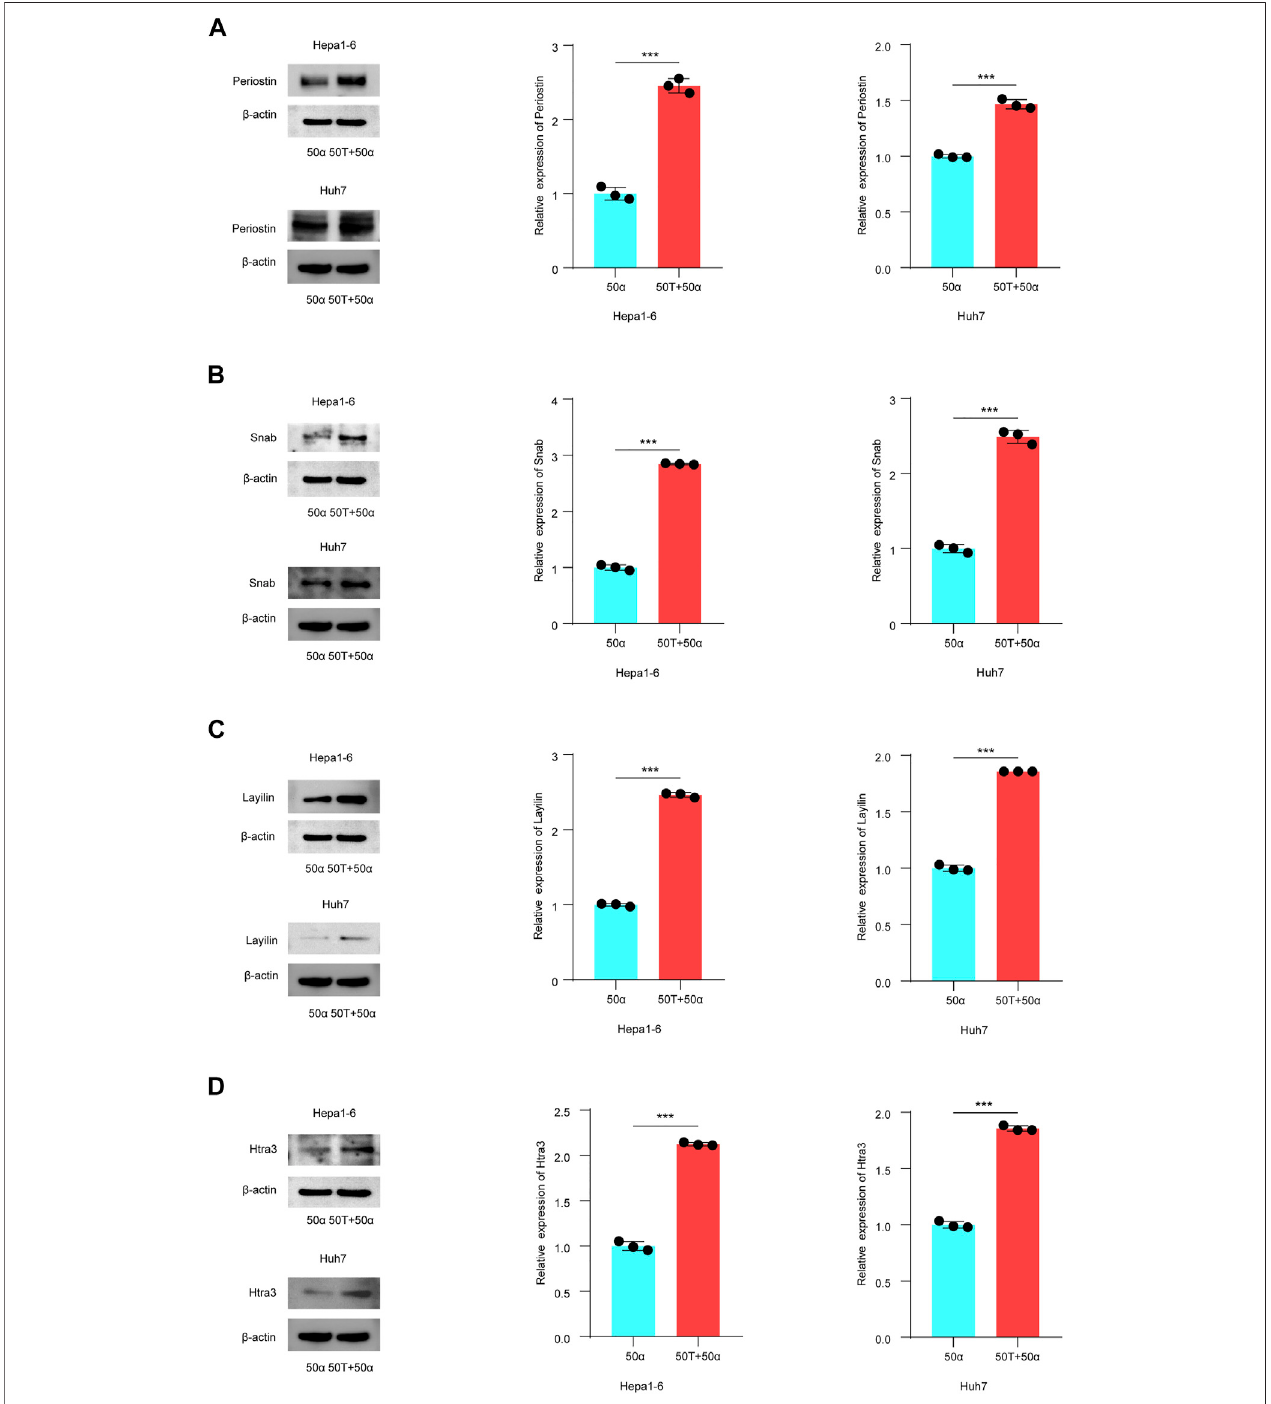
FIGURE6| TMAO regulates the expression ofDEGs related topatient outcome inTNF- α inducedin fl ammatory HCC. (A – D) Western blotting wasused toanalyze the expression levelofPeriostin,Snab, Layilin and Htra3 inHepa1-6 and Huh7 cellstreatedwith 50 ng/ml TNF- α combinedwith 50 μ M TMAO or50 ng/mlTNF- α alone. Grayscale values were analyzed; data are mean ± SD ( n = 3 per group); Student ’ s t-test; ***, p < 0.001.